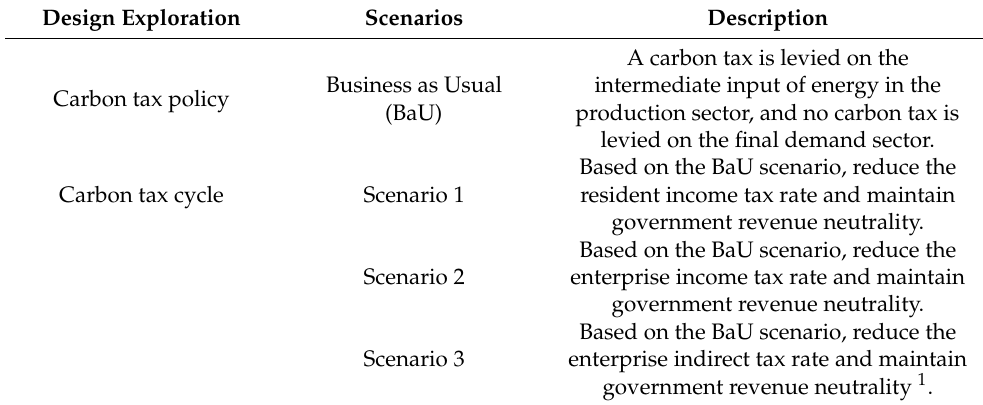
Table 1. Scenarios setting.